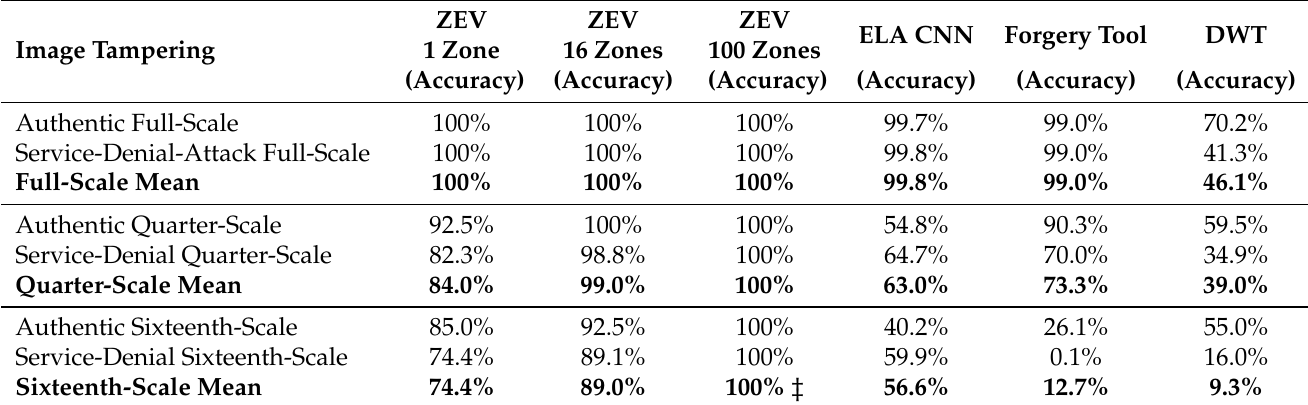
Table 2. Simulated service-denial verification